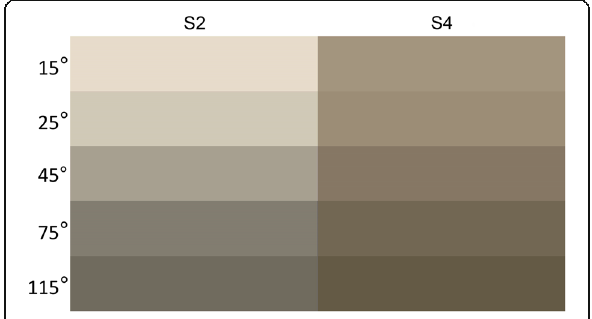
Fig. 5 Visual effects of Al/MnO 2 composite pigments (S2, S4) in different observed angles (D65